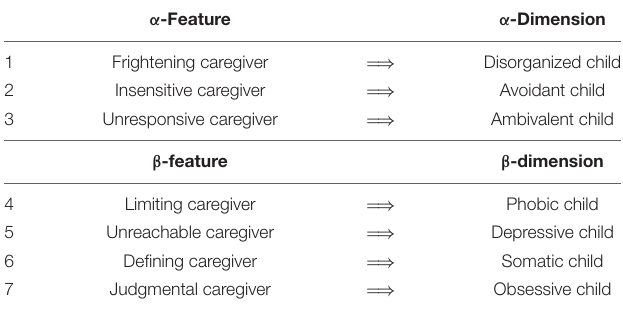
TABLE 2 | Caregiving features and corresponding attachment